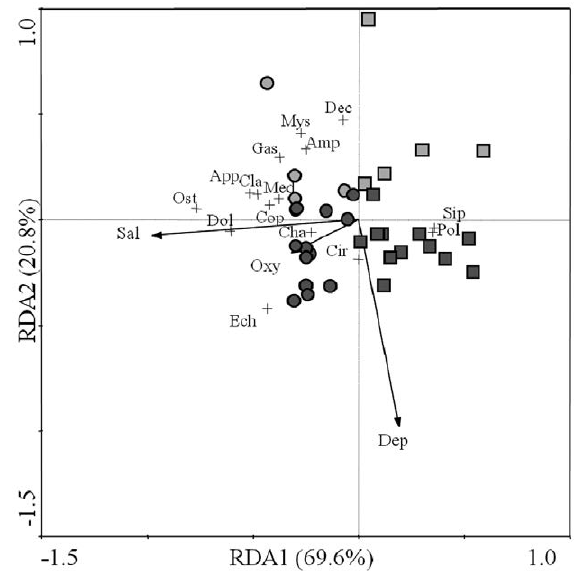
Fig. 5. – Triplot diagram of mesozooplankton major taxonomic groups; explanatory variables and samples in a redundancy analy- sis (RDA) of the first and second axis illustrating the relationships among communities in the grid of stations in Kavala Gulf in the summer of 2002 and 2003. Square and circle points indicate the position of mesozooplankton communities in relation to environ- mental parameters (solid arrows) and species composition (cross points) based on taxon abundance. Mesozooplankton communities from each sampling were coded based on year of sampling and max- imum depth same as in Figure 4B. Taxa abbreviations are shown